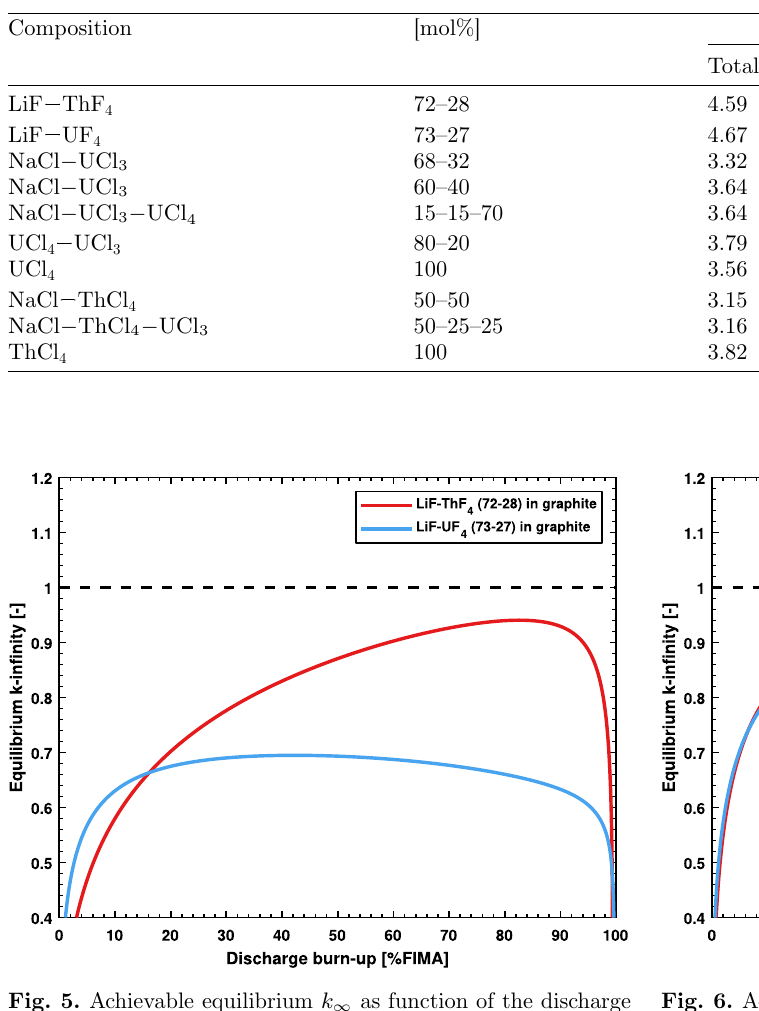
Table 1. Candidate fluoride and chloride fuel salts considered in this work and their properties.